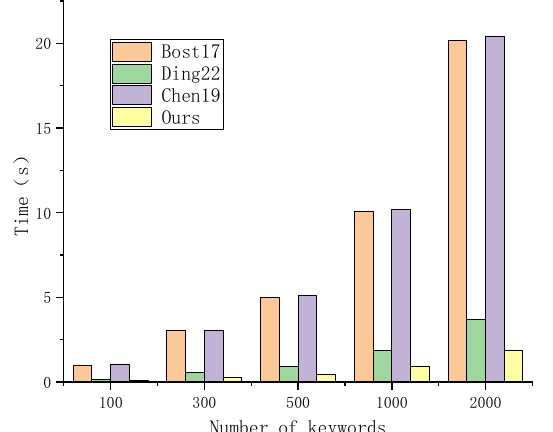
Figure 6. Performance comparison with Bost17 [16], Ding22 [18], and Chen19 [9] in the search